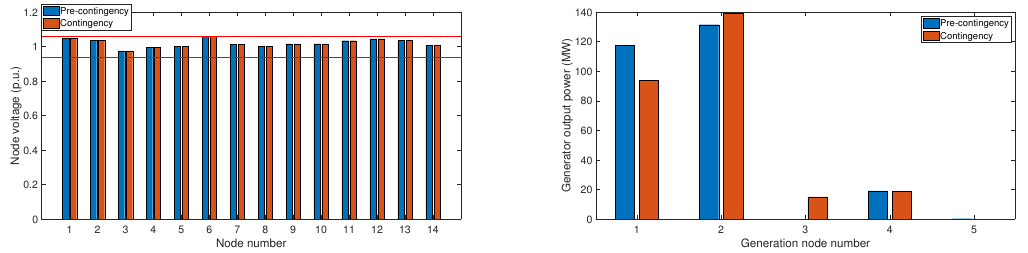
Figure 14. Voltage and power dispatched in the extended power system prior to and after contingency of branch 16 (generation nodes are, respectively, nodes 1, 2, 3, 6, and 8).